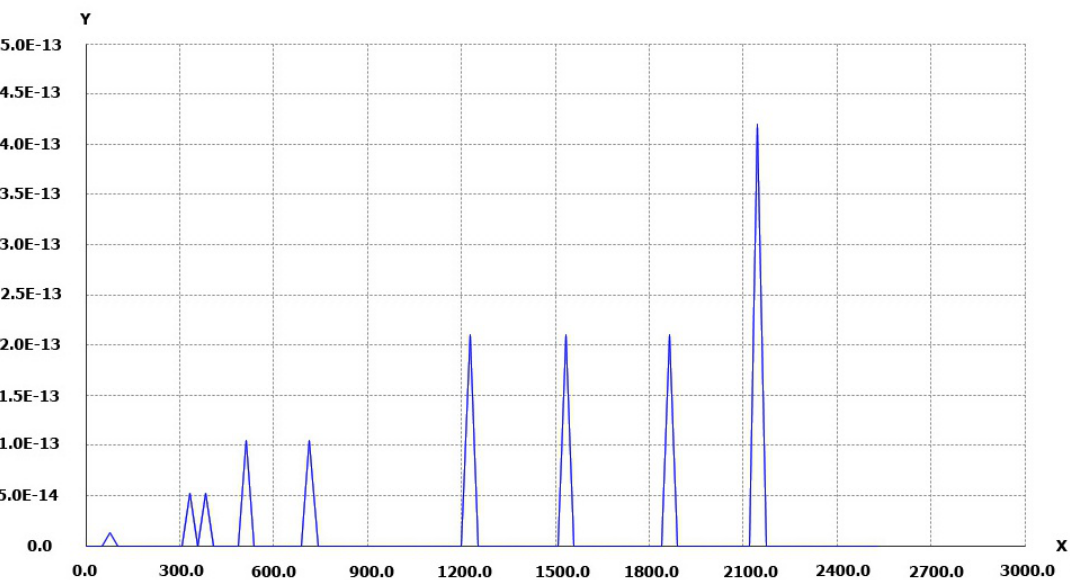
Figure 3. Iterative method applied to a Nikon D700 camera with a 14mm lens. Along the frame diagonal the points are first compensated by what is a normal process of the radial distortion using Equation (1) and then the distortion is applied with the iterative process [40] and the result compared to the original point. On Y-axis, the distance between the original point and the computed reverse point.